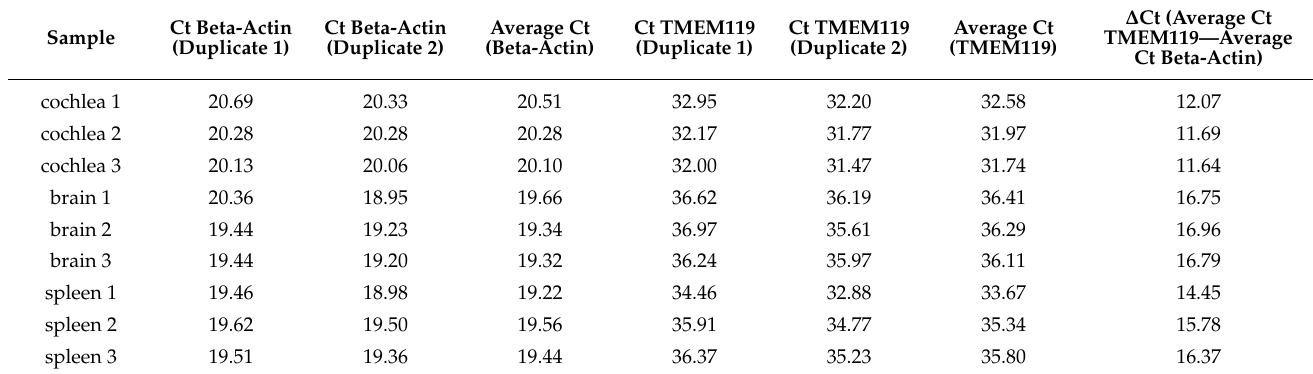
Table 1. Crossing threshold (Ct) values acquired during the real-time RT-PCR for the housekeeping gene β -actin